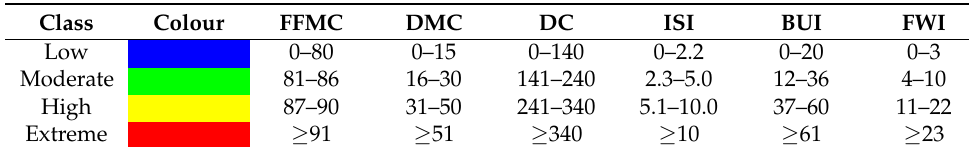
Table 1. Current danger classes and colour scheme [15] used in Ontario for each of the six Fire Weather Index System components: Fine Fuel Moisture Code (FFMC), Duff Moisture Code (DMC), Drought Code (DC), Buildup Index (BUI), Initial Spread Index (ISI) and Fire Weather Index (FWI).